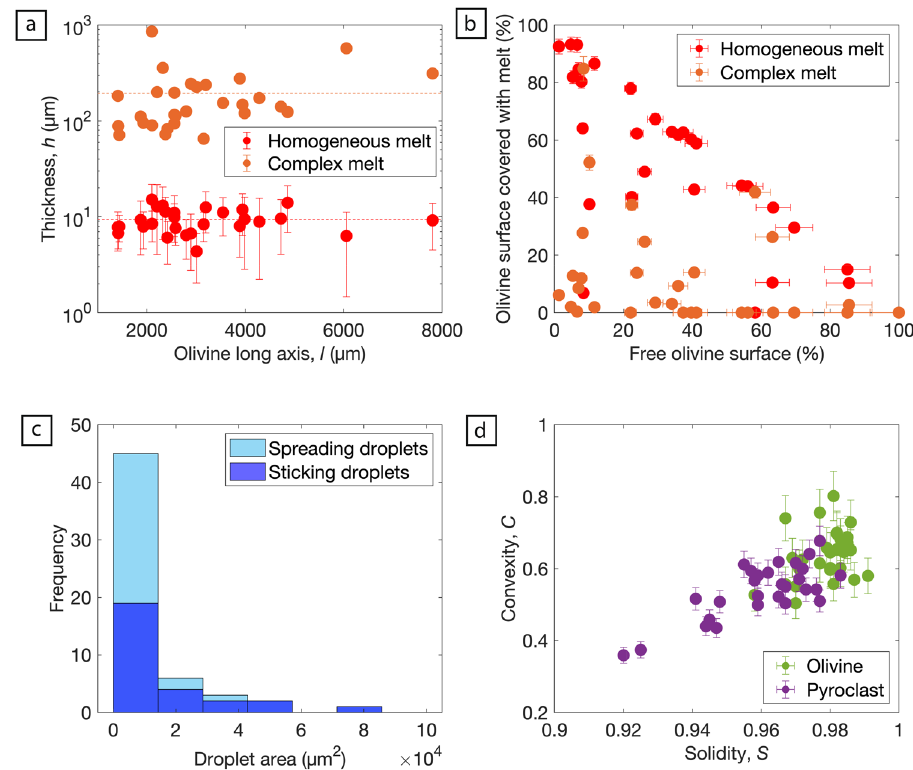
Fig. 3 Quantitative image analysis results. a The mean thickness of the homogeneous, quenched melt layer (red) and the maximum thickness of the complex, crystal rich, vesicular melt coating (orange) as a function of olivine long axis length. Error bars represent the thickness variability, unique to each individual pyroclast. b The amount of free olivine crystal surface plotted against the proportion (%) of the olivine crystal surface covered by homogeneous melt and complex melt. Error bars represent one standard deviation obtained by repeat measurements on a representative pyroclast. c A frequency histogram ( n = 57) of the melt droplet area (spreading and sticking) for all pyroclasts analysed in this study. d Convexity, C and solidity, S shape factors for the central olivine crystal and the entire pyroclast (olivine crystal and coating). Error bars represent one standard deviation obtained by repeat measurements on a representative pyroclast. All accompanying data can be found in the online Supplementary Data